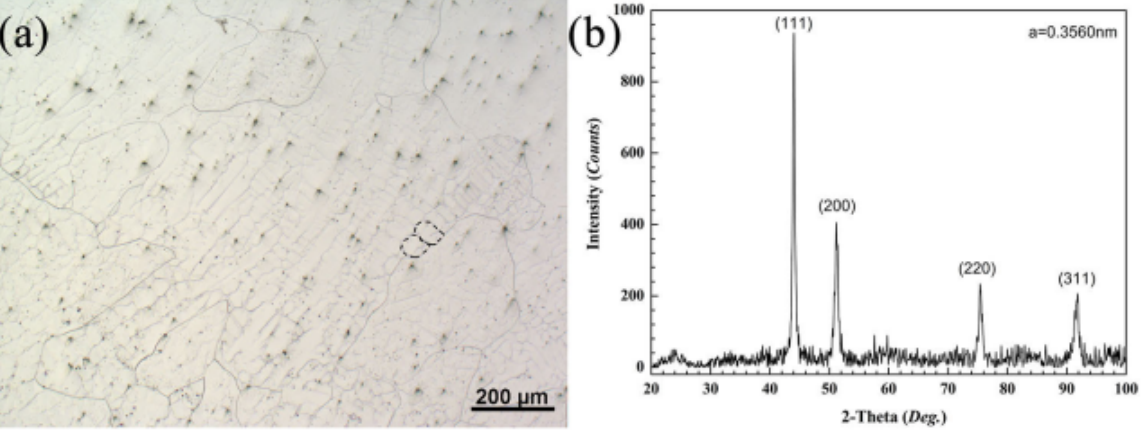
Figure 2. Microstructure ( a ) and the X-ray diffraction (XRD) patterns ( b ) of the CrCoNiAl 0.014